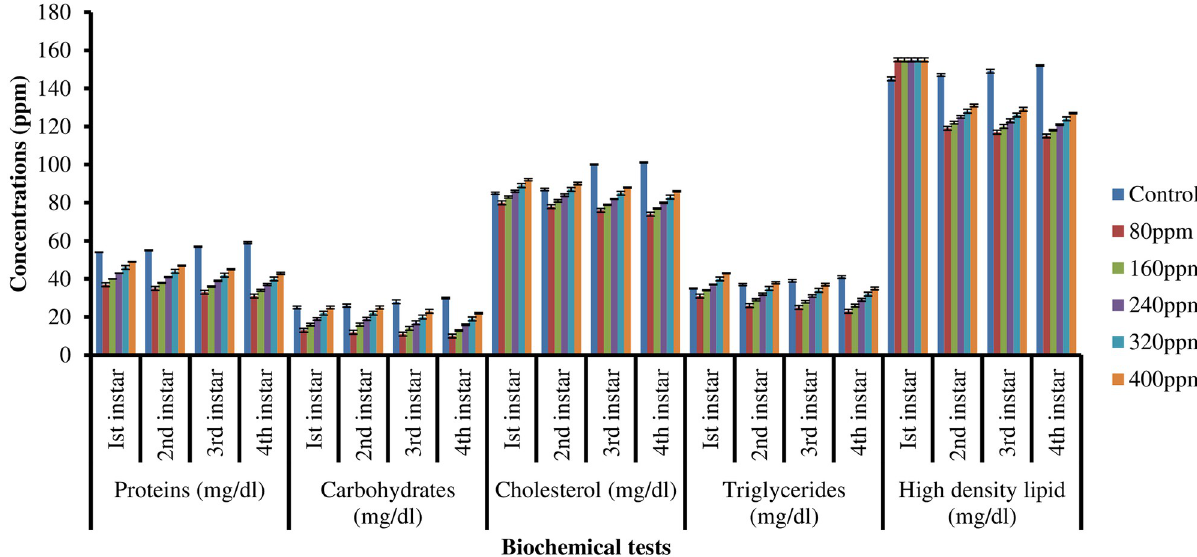
Fig 4. Proteins, carbohydrates, cholesterol, triglycerides and high density lipid estimation of I st , 2 nd , 3 rd , and 4 th instars larvae of C . quinquefasciatus in different concentrations of M . piperita leaves extract in a water solvent.